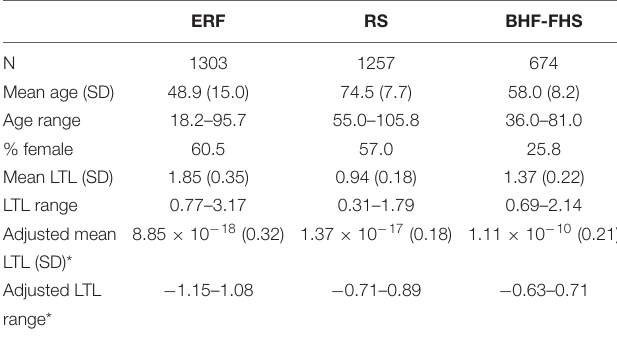
ERF = Erasmus Rucphen Family study; RS = Rotterdam Study; BHF-FHS = British Heart Foundation Family Heart Study; N = Number of variants; SD = Standard Deviation, LTL = Leukocyte Telomere Length. *LTL values were adjusted for age and sex and information on residuals is